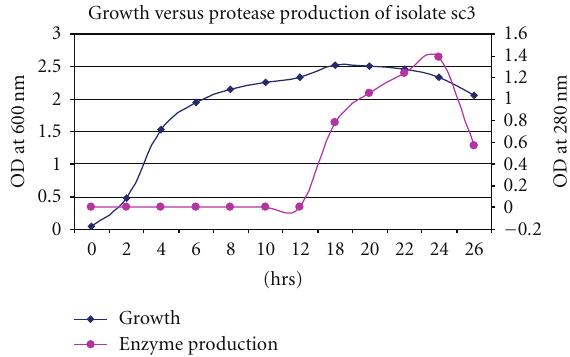
Figure 3: Growth versus Protease production in Aeromonas hydrophila strain An4.